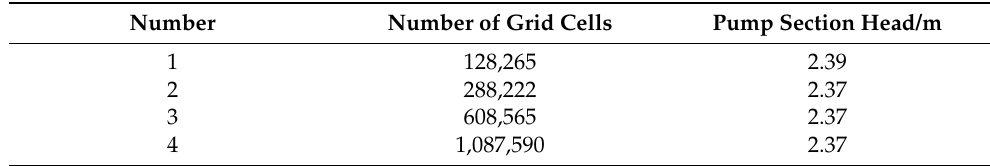
Table 2. Sensitivity analysis of pump section